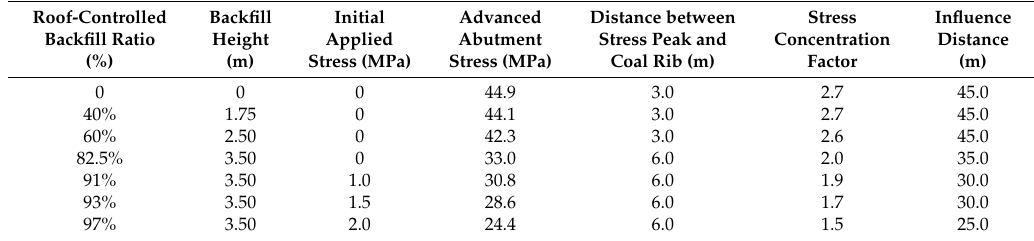
Table 4. Comparison of distribution of advanced abutment stress.